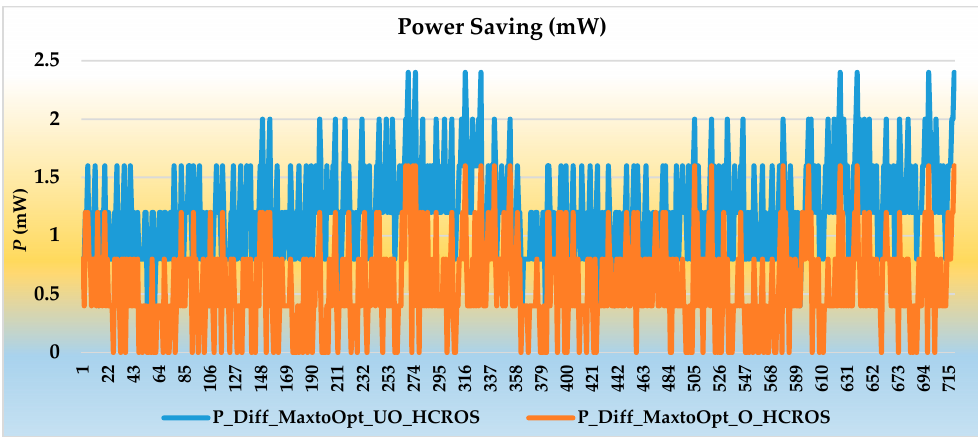
Figure 14. Power savings in un-optimized and optimized HCROS for all 720 I/O links.